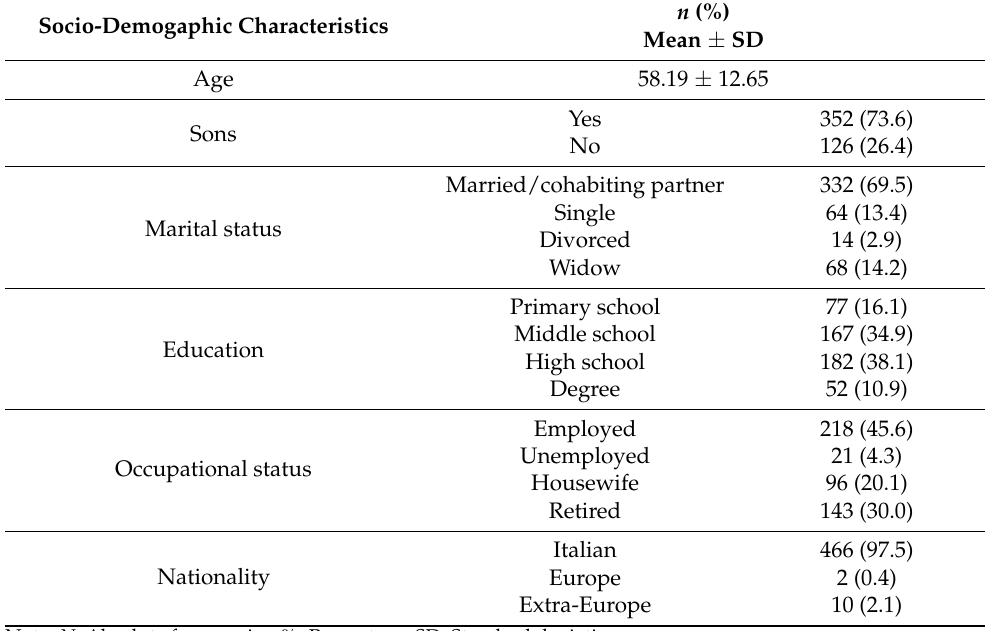
Table 1. Socio-demographic characteristics of the sample ( N =